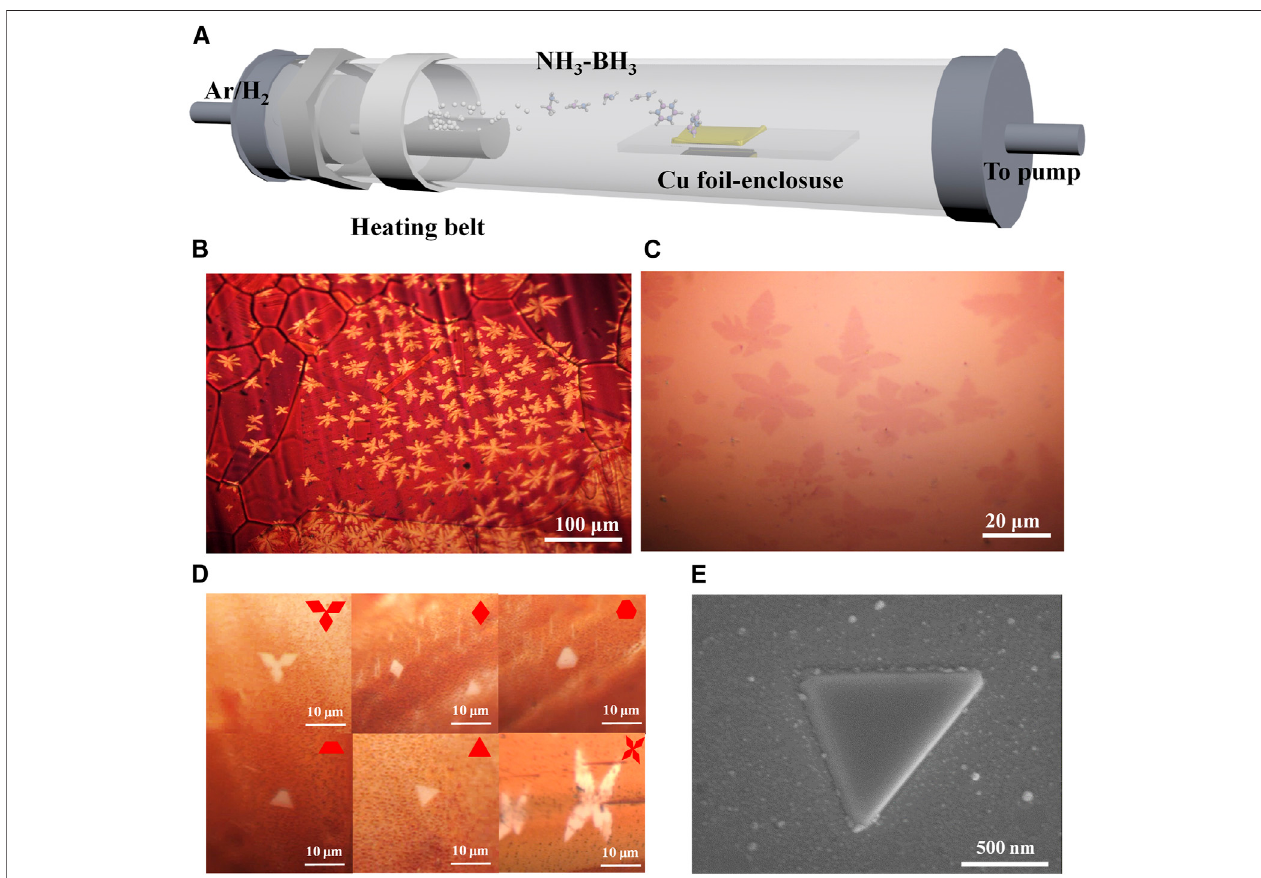
FIGURE1| LPCVDsynthesisofmonolayer h -BNnano fl akesforthefollowingAFMmeasurements. (A) SchematicoftheLPCVDsystemformonolayer h -BNgrowth using Cu-foil enclosure. (B) Optical image of h -BN/Cu after oxidation. (C) Optical image of the wet-transferred monolayer h -BN on 300 nm thick SiO 2 /Si substrate. (D) Opticalimagesof h -BNnano fl akesonthecopperfoilwithvariousregularshapes.Insets:theschematicof h -BNnano fl akes. (E) SEMimageofan h -BNmonolayeronthe copper substrate after oxidation. The brighter edge is due to the height difference between h -BN and copper oxide, which has been further con fi rmed by the following AFM